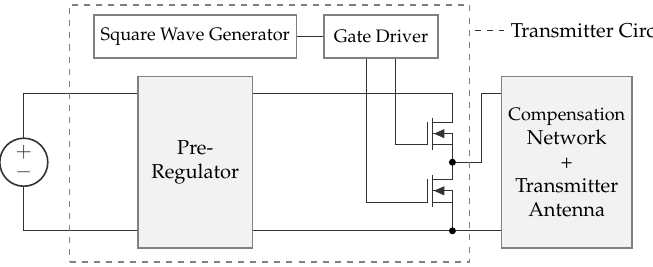
Figure 3. Transmitter example with pre-regulator and half-bridge